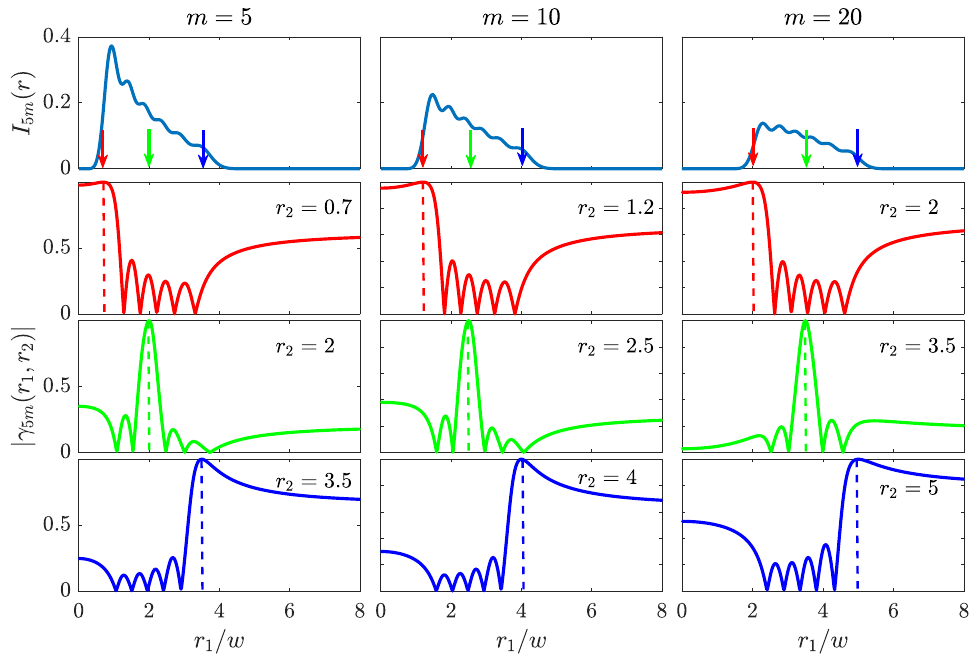
Figure 6. Upper row: intensity profile given by Equation (35) for N = 5 and several values of m . Second, third and fourth rows: absolute value of the degree of coherence for relative to a point located at a distance r 2 from the source center (indicated with an arrow on the intensity profile and a dashed line in the degree of coherence profile).